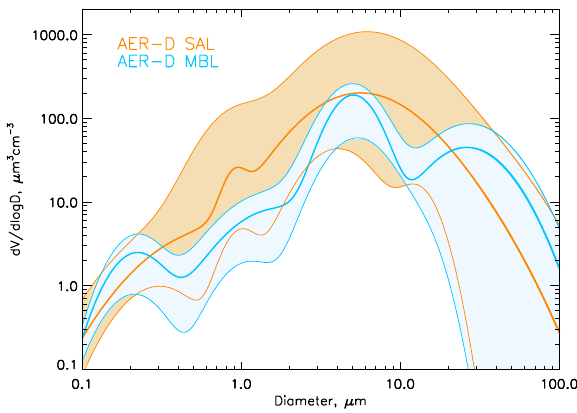
Figure 6. AER-D mean logfit size distribution from the MBL (blue) and SAL (orange). Shading indicates the range between minimum and maximum values, and the central solid line shows the mean.